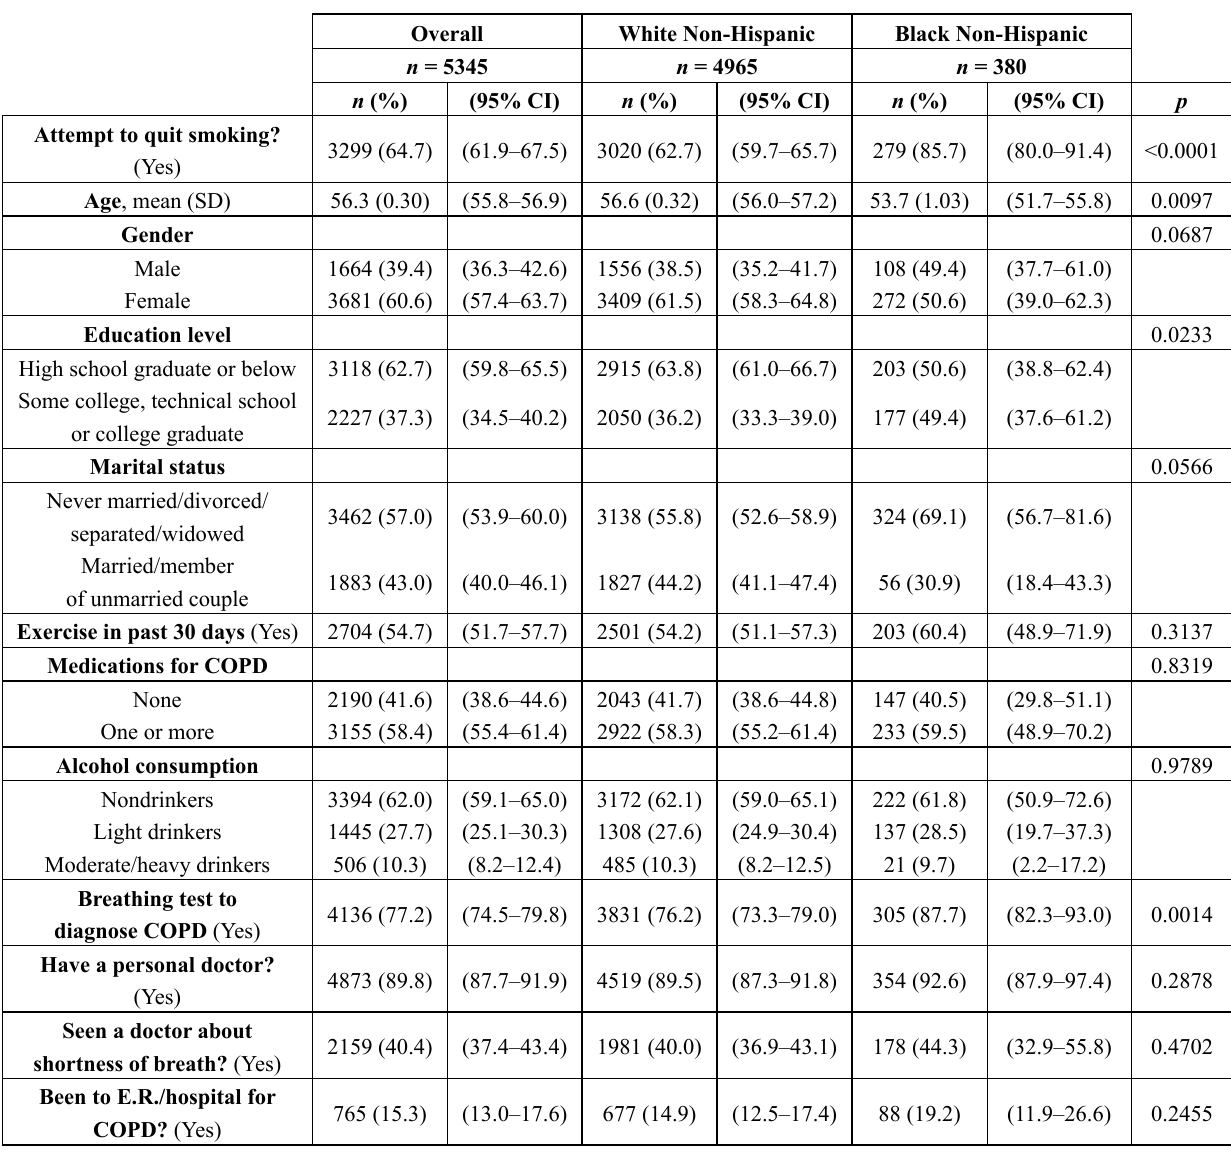
Table 1. Healthcare utilization factors and demographic characteristics of current smokers with COPD: frequency, weighted prevalence and 95% confidence intervals, overall and by race/ethnicity, 2011 BRFSS, n =